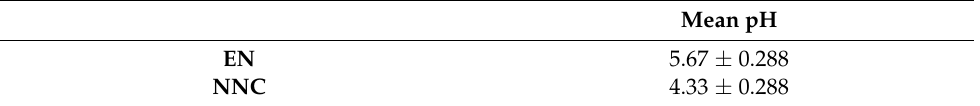
Table 2. pH of freshly made empty nanocapsules (EN) and nicotine containing nanocapsule (NNC) suspensions. Results are displayed as mean ± standard deviation.